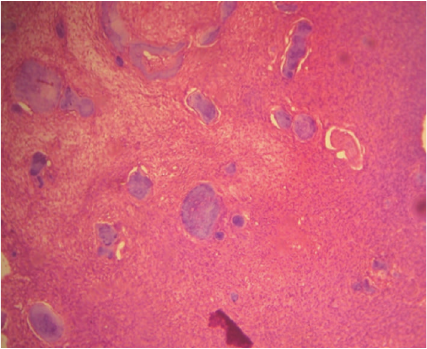
Figure 4: Fibro-cellular stroma containing cementum-like hard tissue calcifications (H&E stained section